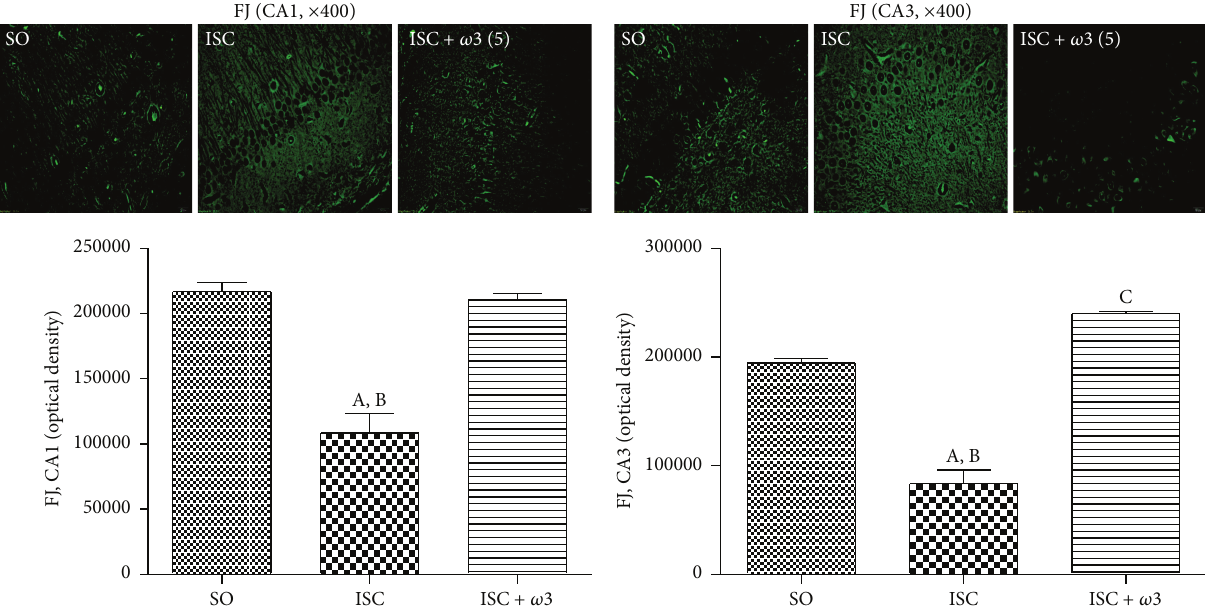
Figure 5: 𝜔 3 treatments of ischemic animals (3 animals per group) drastically decreased the neuronal degeneration (visualized by an intense fluorescence to Fluoro-Jade) in hippocampus and cortex. The effects in CA1 and CA3 and DG are represented by photomicrographs and quantitative measurements performed with the Image J software, from 3 to 6 fields. The groups are sham-operated (SO); ischemic (ISC) untreated, and ischemic after 𝜔 3 treatments (5mg/kg, for 7 days). CA1: (A) versus SO, q = 10.98 ∗∗∗ ; (B) versus ISC + 𝜔 3, q = 10.34 ∗∗∗ . CA3: (A) versus SO, q = 14.57 ∗∗∗ ; (B) versus ISC + 𝜔 3, q = 20.55 ∗∗∗ ; (C) versus SO, q = 5.979 ∗∗ (one-way ANOVA and Newman-Keuls test as the post hoc